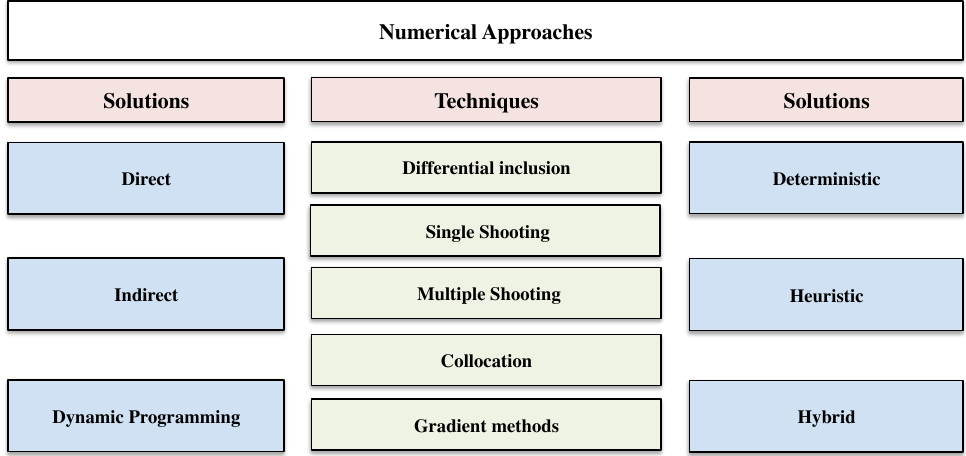
Figure 6. Numerical approaches, techniques and solutions for